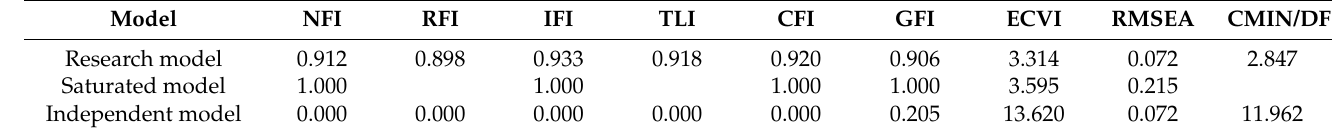
Table 5. Goodness of fit of nurse manager competency model of tertiary general